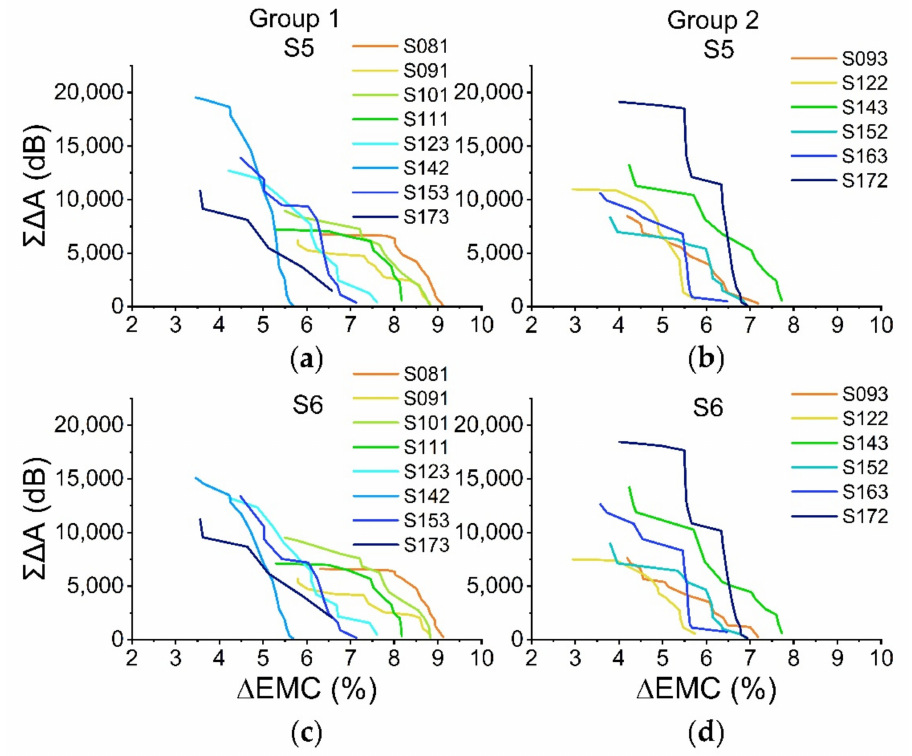
Figure 14. Σ∆ A (dB) vs. ∆ EMC (%). ( a ) Group 1, S5; ( b ) Group 2, S5; ( c ) Group 1, S6; and ( d ) Group 2, S6.